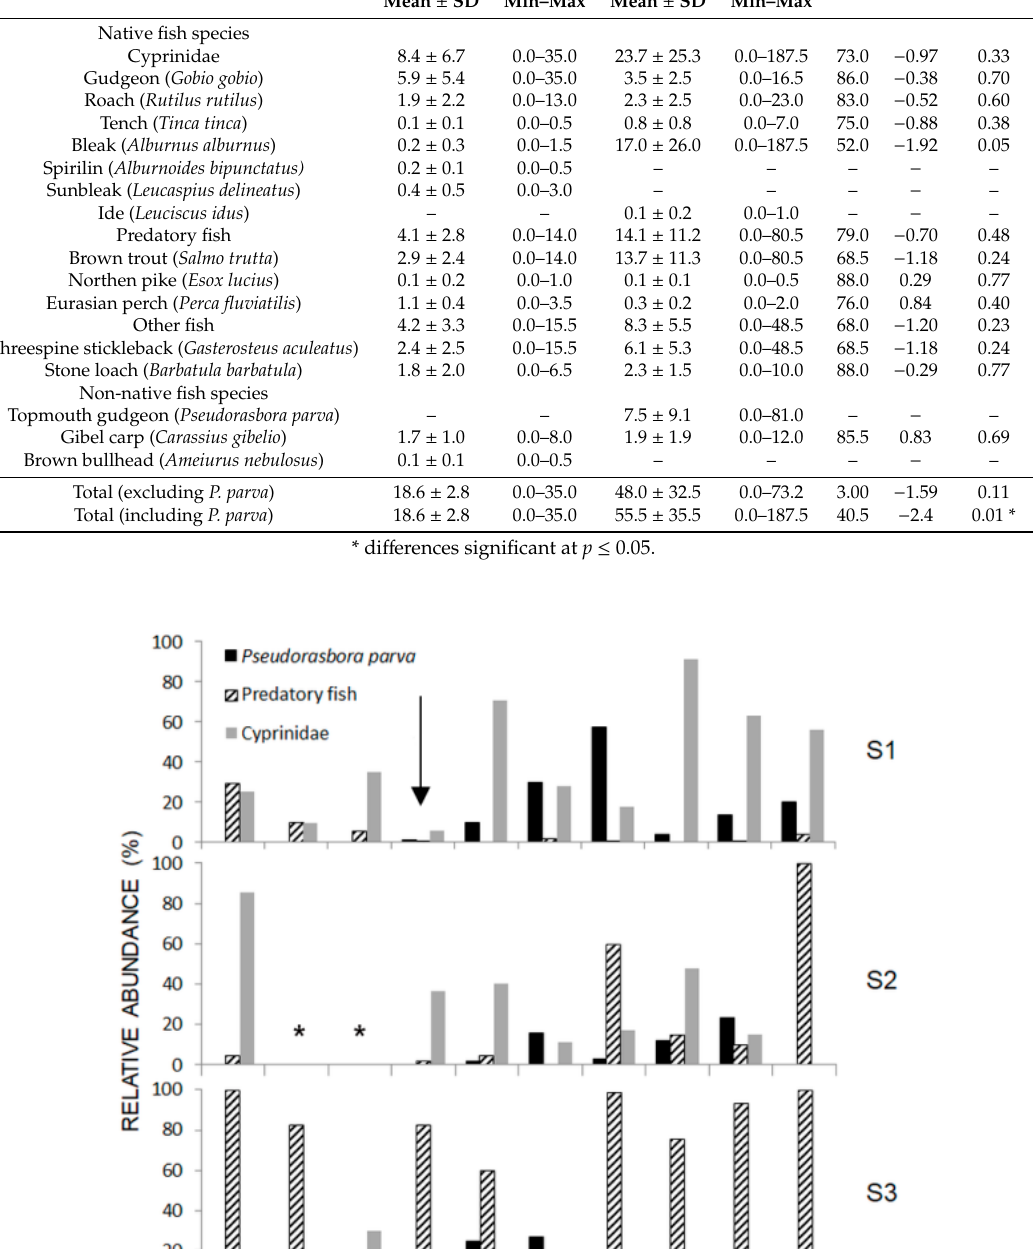
Table 3. Mean ( ± SD) density (per 100 m 2 ) (CPUE) of native and non-native fish species observed before (autumn 2003–summer 2005; n = 9) and after (autumn 2005–autumn 2007; n = 21) the first recording of P. parva in the Ciemi˛ega River; Min–Max—minimum–maximum, U, Z—the statistics of a Mann–Whitney test. Before Finding P. parva Groups and Fish Species Before Finding P. parva After Finding P. parva